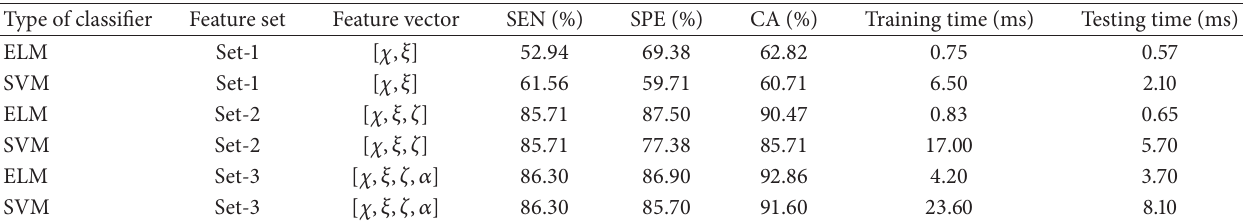
Table 1: Performance of ELM and SVM classifier for different sets of the proposed feature vectors.